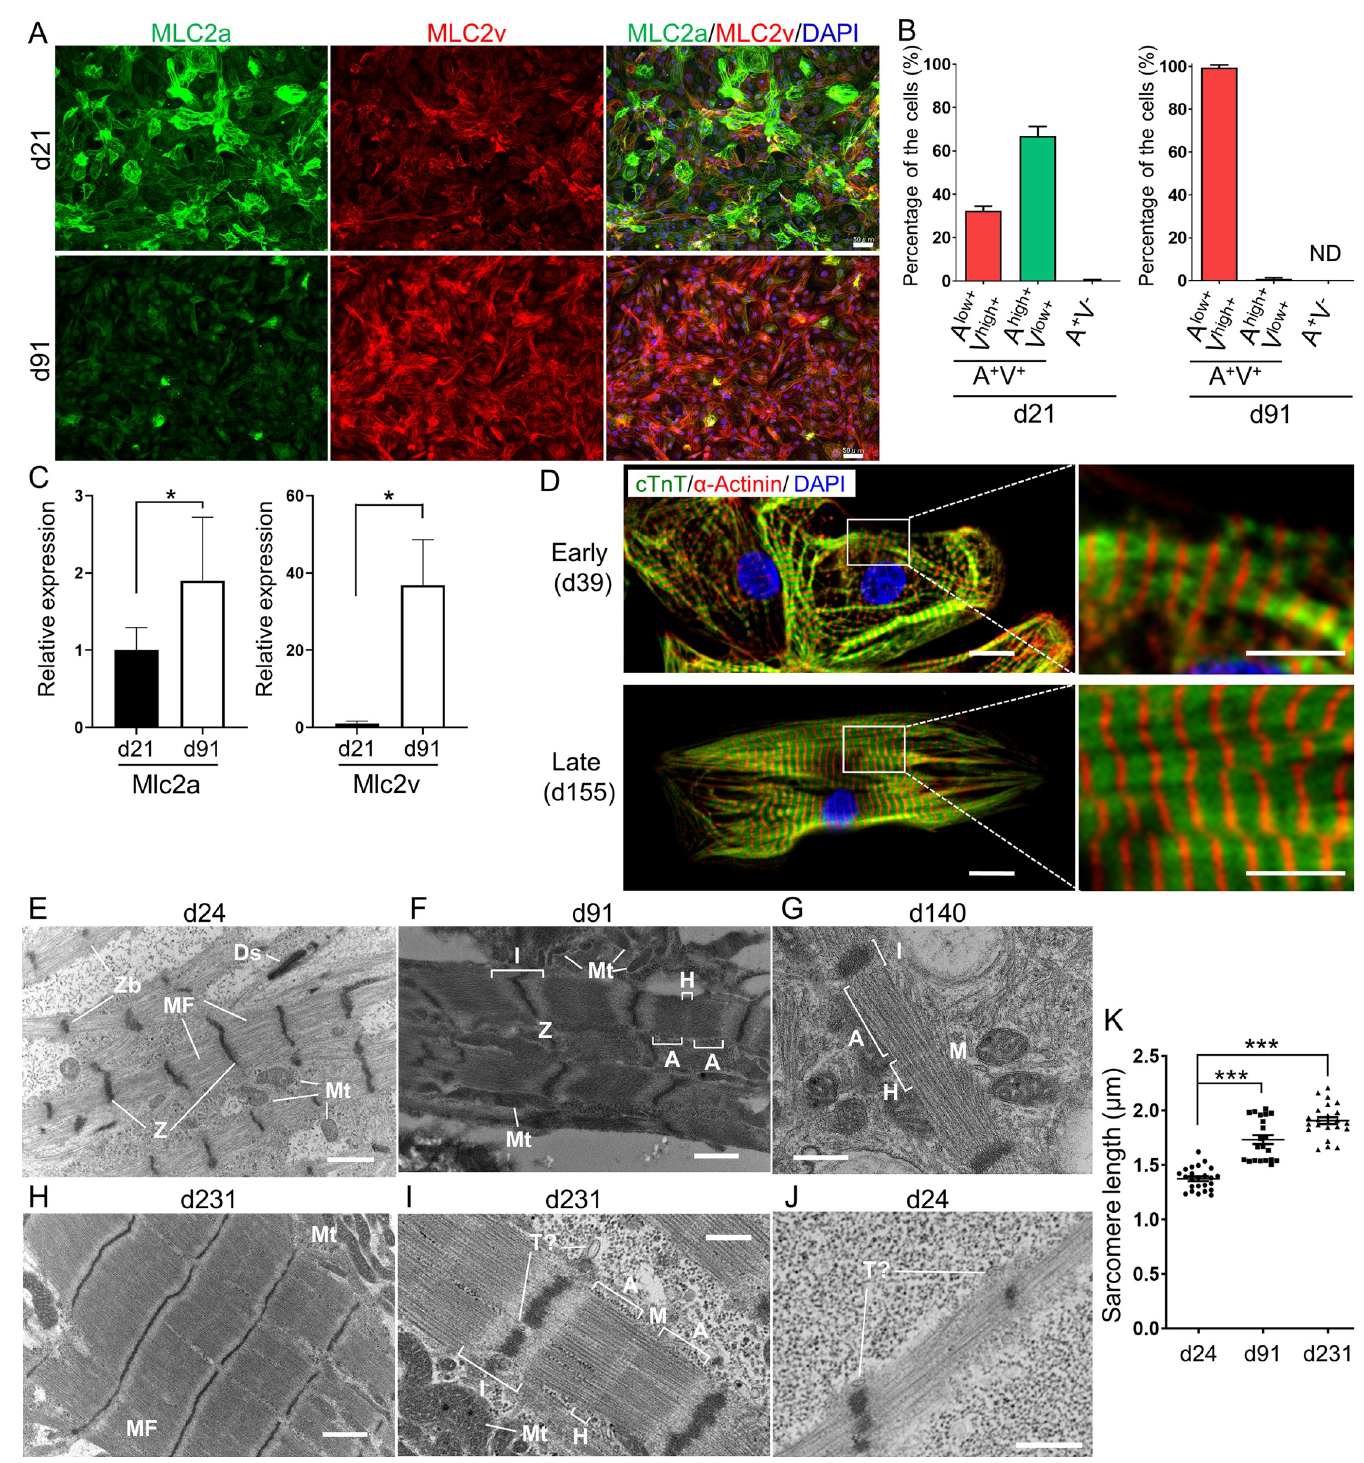
Fig 4. Structural maturation and chamber specification of hiPSC-derived CMs after long term culture. (A, B) Immunostaining of MLC-2a and MLC-2v. (A) Immunofluorescent staining of MLC-2a (Green), MLC-2v (Red), and DAPI (Blue) in d21 and d91 CMs. Scale bar, 50 μ m. (B) Quantification of MLC2a and MLC2v immunostaining of d21 and d91 CMs. Data are means ± SD. (n = 4). A+V+: MLC-2a-positive MLC-2v-positive, ventricular CMs; A high+ V low+ : MLC-2a-high positive MLC-2v-low positive, immature ventricular CMs; A low+ V high + : MLC-2a-low positive MLC-2v-high positive, relatively mature ventricular CMs; A+ V-: MLC-2a- positive MLC-2v-negative, atrial CMs; ND: not detected. (C) qPCR of relative mRNA expressions of Mlc2a and Mlc2v in CMs on d21 and d91. The mean of d21 was set